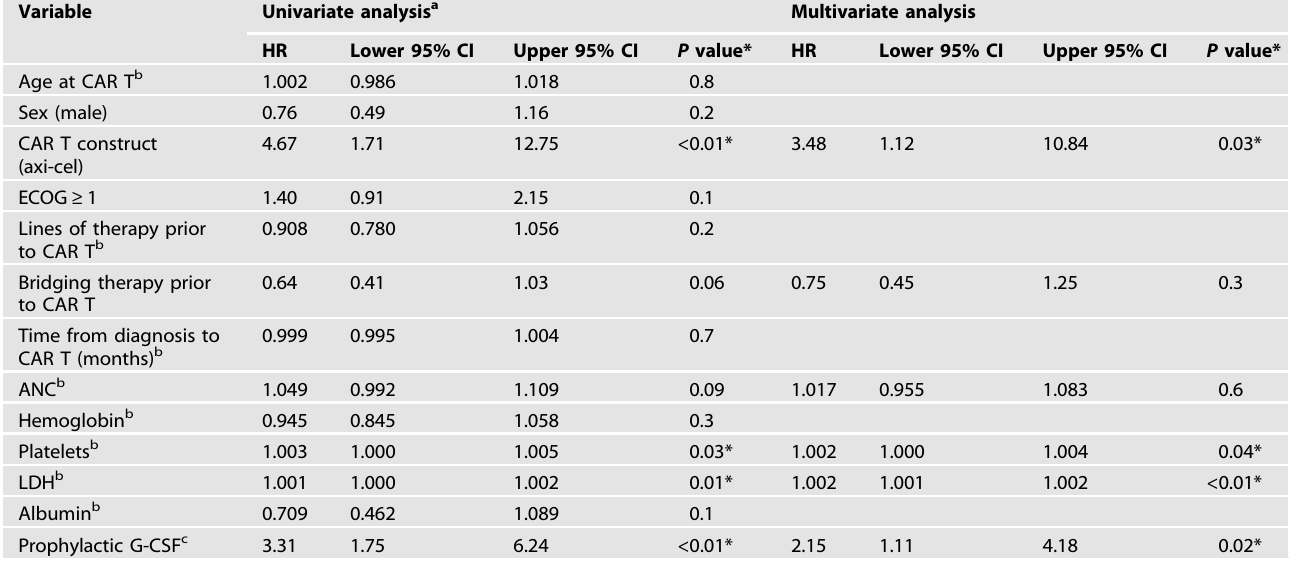
Table 4. Cox proportional hazards model for Grade ≥ 2 CRS in lymphoma cohort. Variable